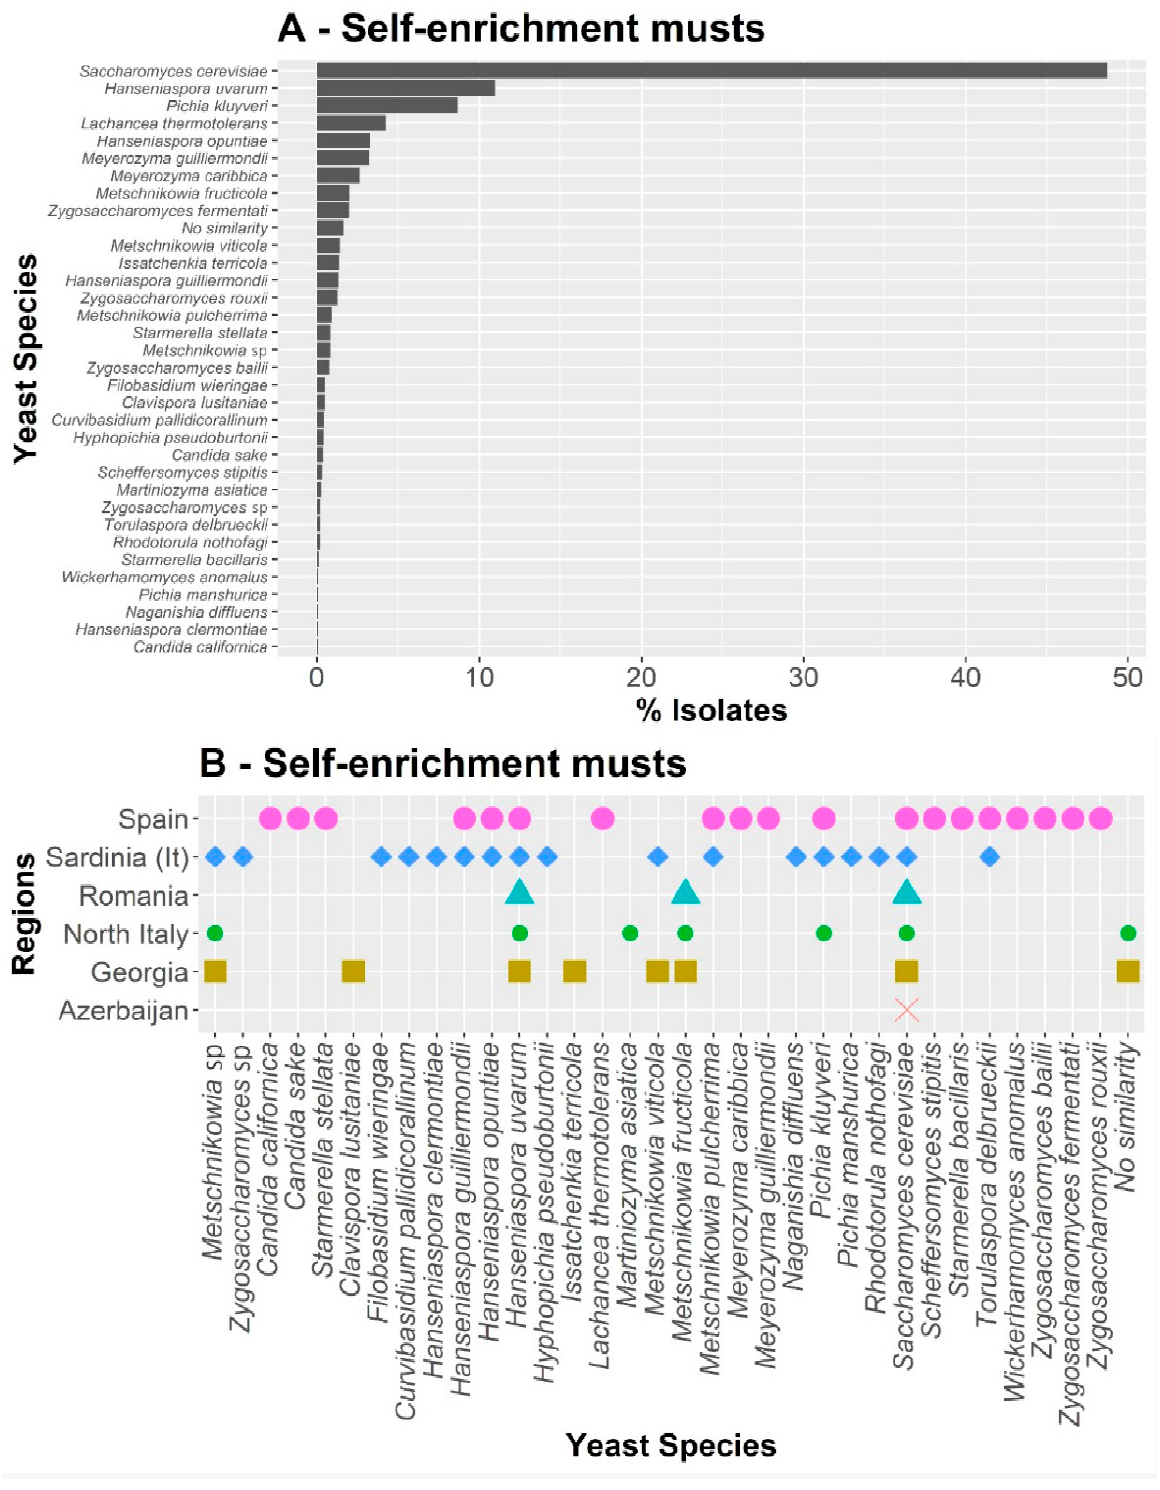
Figure 3. Distribution of culturable species isolated at both the intermediate point and the end of the spontaneous fermentation, as evaluated by the consumption of sugars and the release of carbon dioxide ( A ), and the species found in each region ( B ). In this case, no unique species were found in Azerbaijan or in Romania.